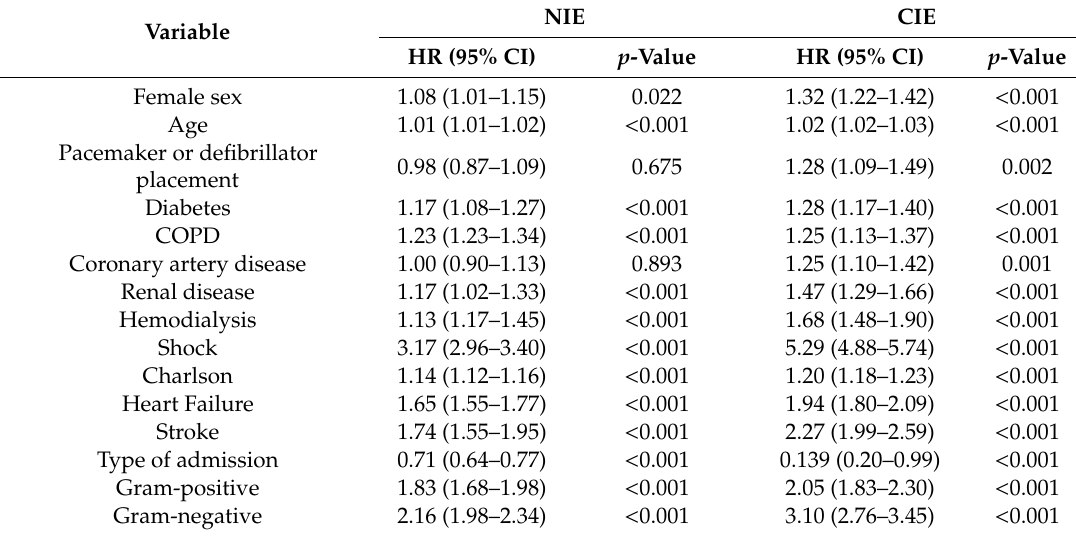
Table 4. Overall and trends of mortality in Spain from 1997 to 2014 classified by gender, age group, and mode of acquisition of infective endocarditis.